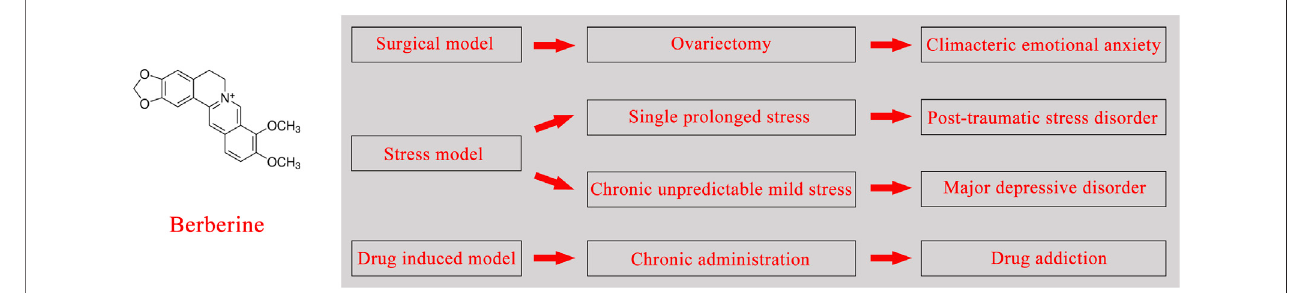
FIGURE 1 | Chemical structural formula of berberine, associated depression models, and clinical